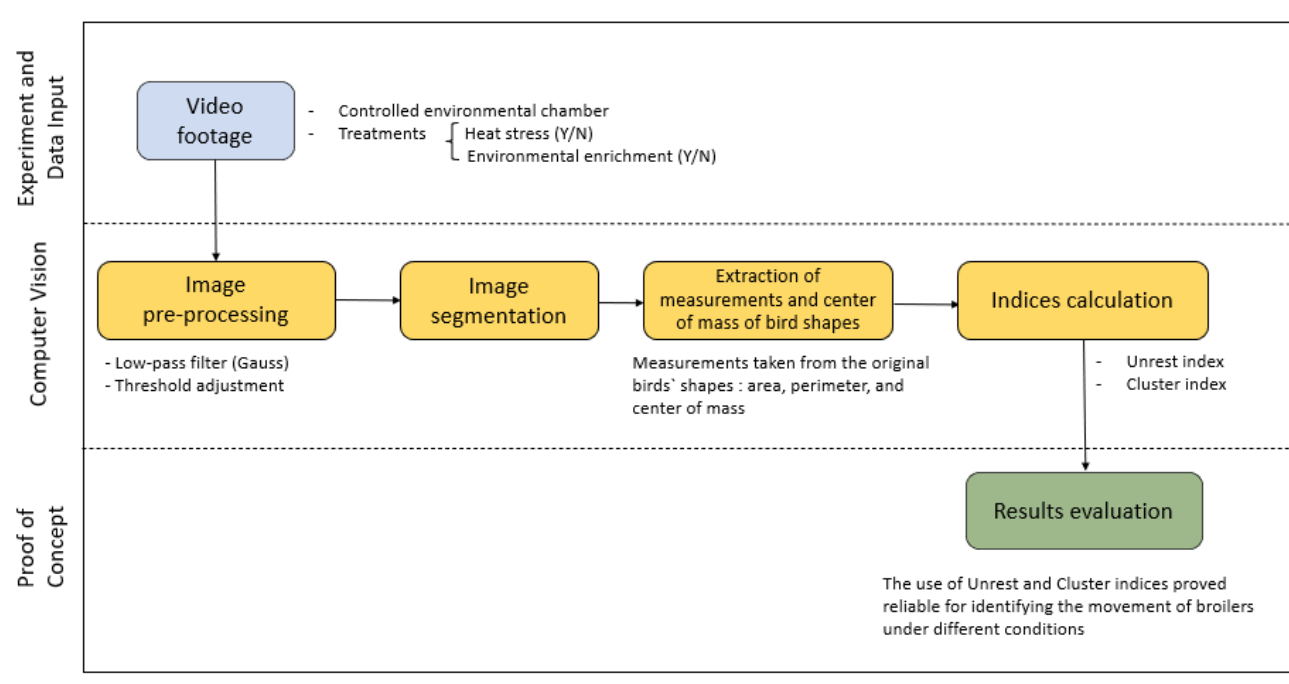
Figure 2. Diagram of data input and output of the tests.